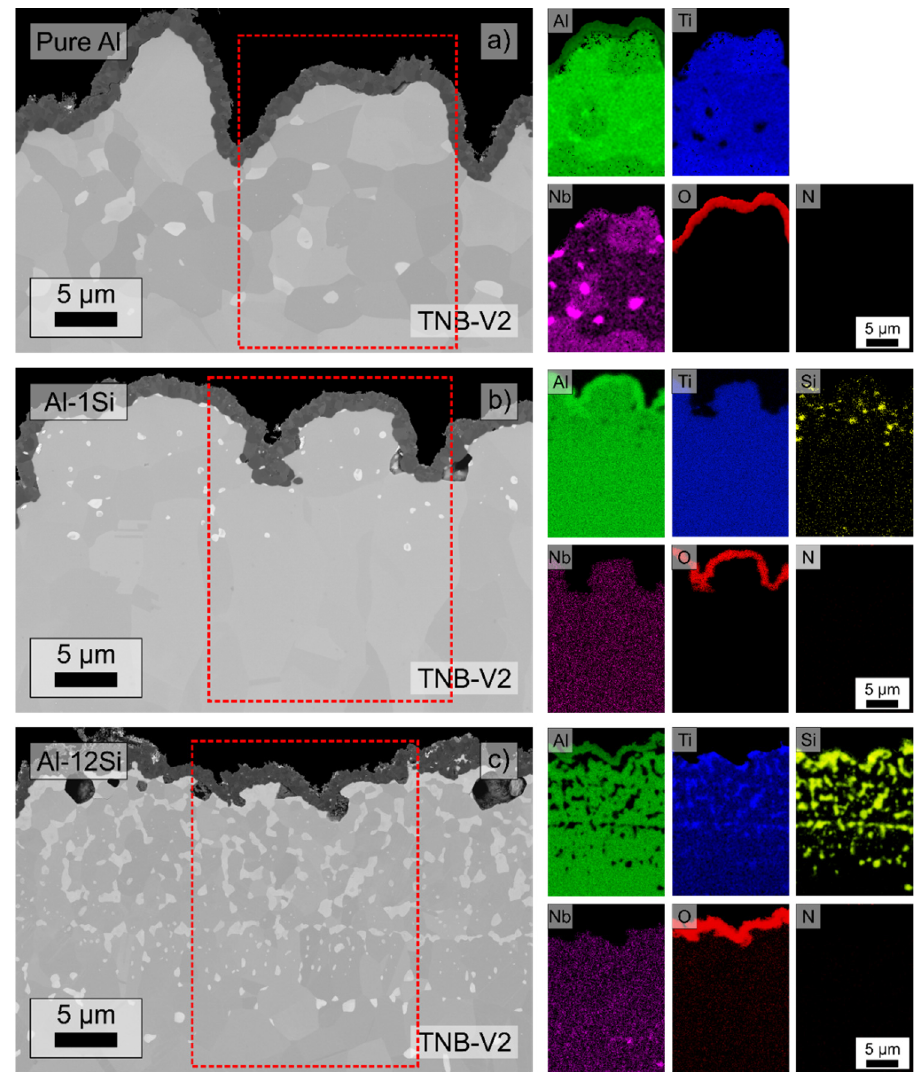
Figure 7. SEM cross sections in the backscatter mode of the pure Al ( a ), as well as Al-1Si ( b ) and Al-12Si ( c ) coatings (all in at.%) after 1000 cycles at 900 °C (1 h each cycle) with the corresponding EDS elemental mappings of the red marked area.